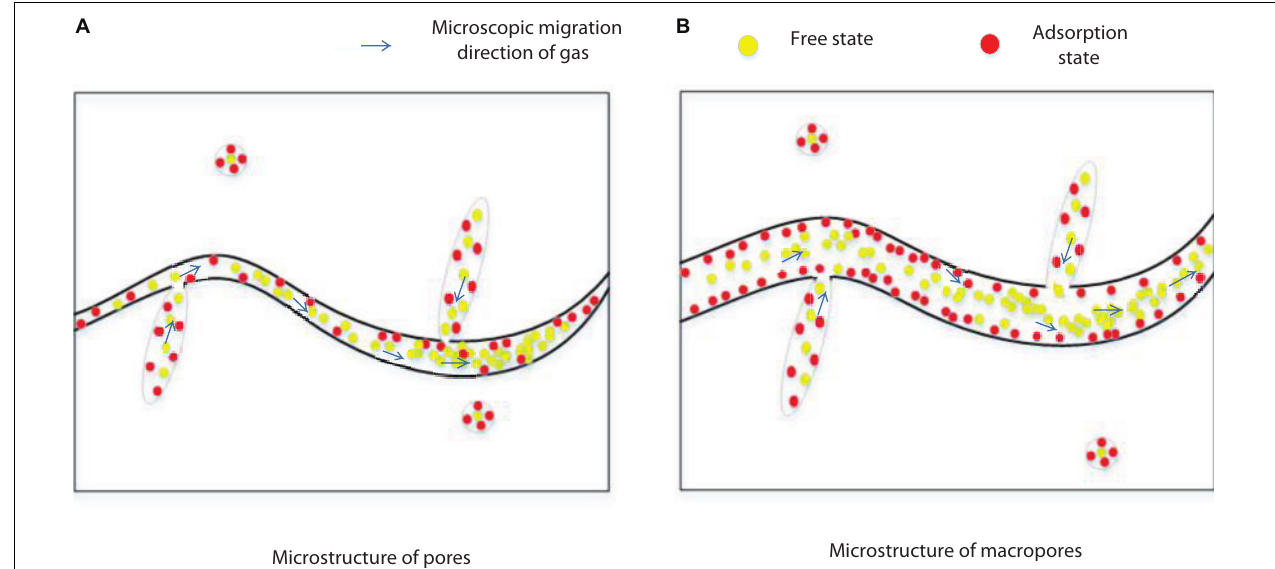
FIGURE 17 | Comparison of the microstructure of large and small pores. (A) represents the microscopic pores with poor physical properties, and (B) represents the microscopic pores with better physical properties.